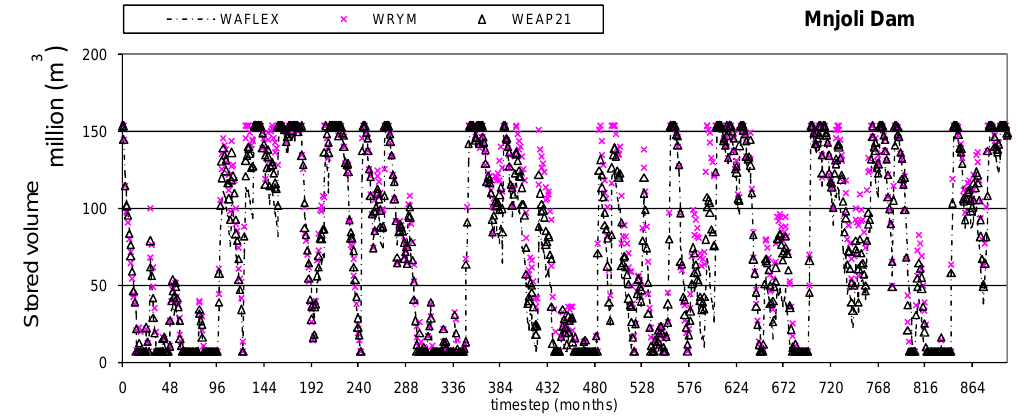
Figure 5 Model performance for Mnjoli dam operation for Scenario 3. Reservoir trajectory during 75 years of simulation.